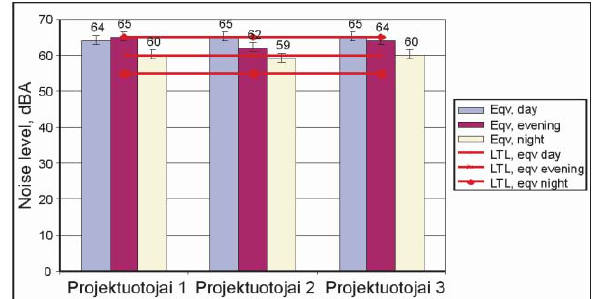
Fig. 16. Dynamics of equivalent noise levels in Projektuotojai street within twenty four